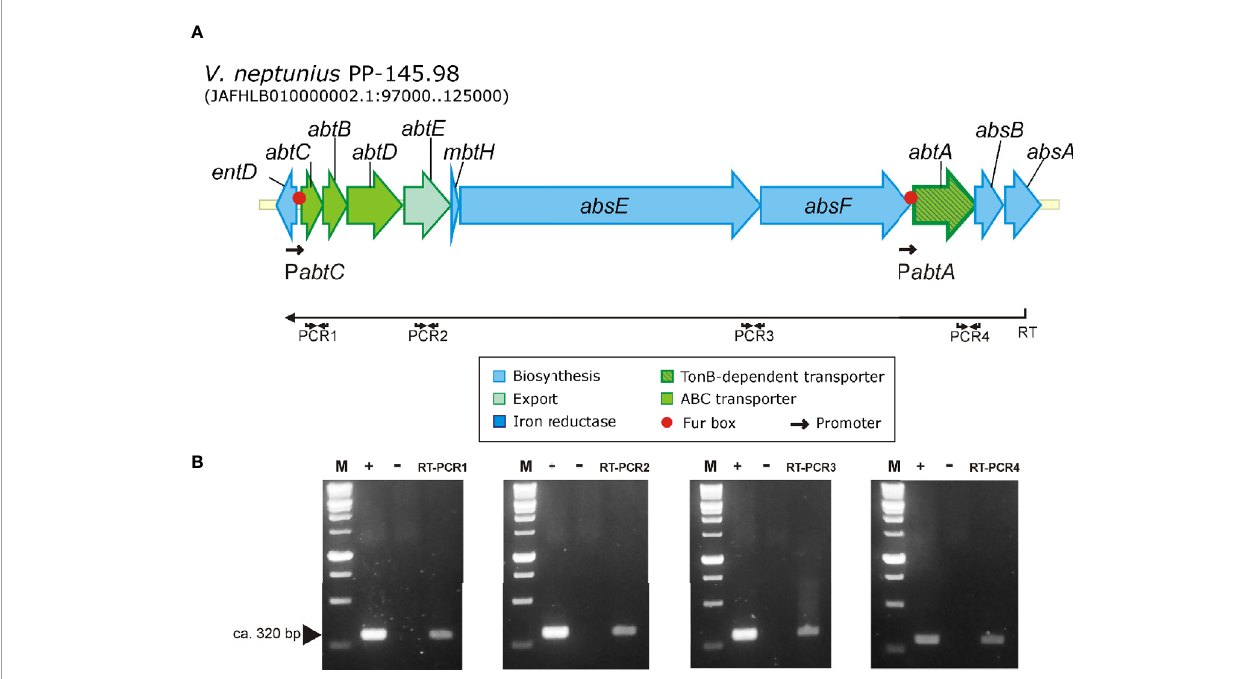
FIGURE 7 | Results of RT-PCR reactions designed to analyze the transcription of the amphibactin gene cluster in V. neptunius PP-145.98. (A) Genetic map of the gene cluster encoding the amphibactin in V. neptunius PP-145.98. (B) An appropriate primer (Primer RT, Table S1 ), located at the 3 ’ -end of absA gene, was used to obtain a cDNA (denoted as RT in the fi gure) that was then used as template for 4 PCR reactions targeted between abtC 3 ’ -end and 5 ’ -end abtD (PCR1), abtE (PCR2), between absE 3 ’ -end and absF 5 ’ -end (PCR3), and between abtA 3 ’ -end and absB 5 ’ -end (PCR4). M, size marker from 100 to 1,000 bp; +, positive control PCR using genomic DNA as template; − , negative control PCR using total RNA without reverse transcriptase. RT-PCR1-4 shows the ampli fi cation result of the 4 different